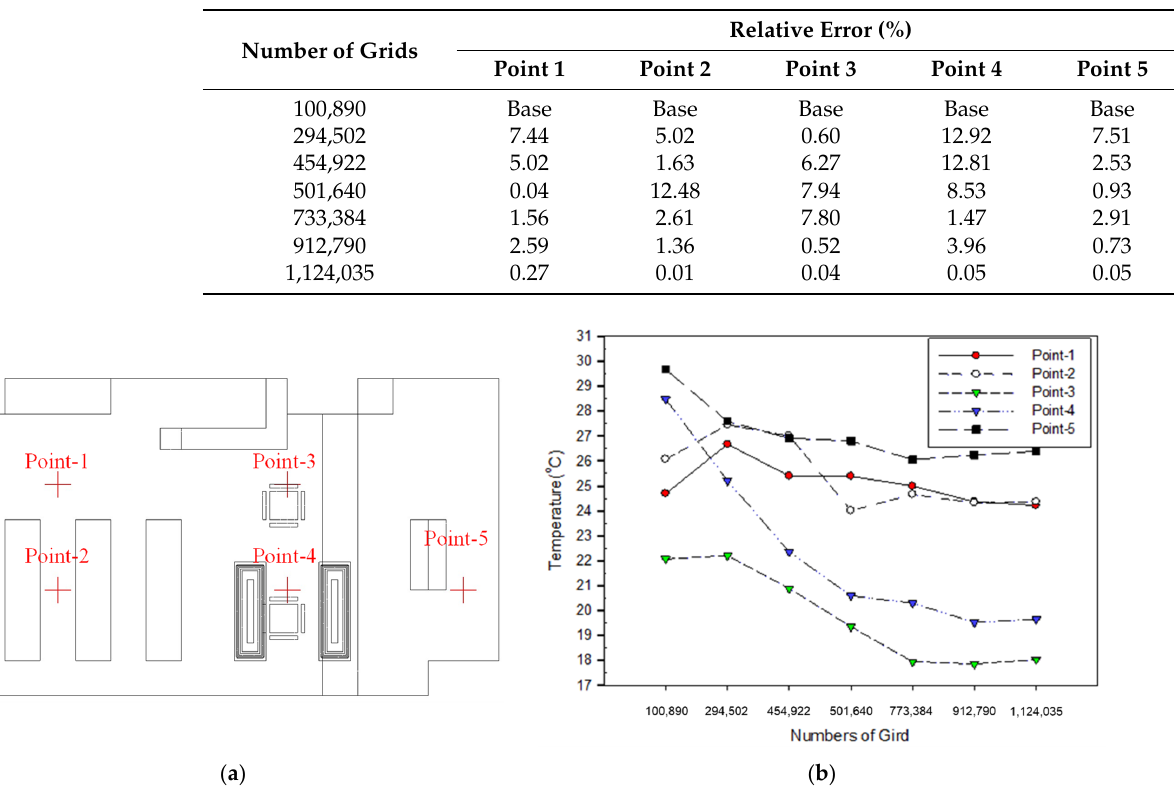
Figure 4. Grids test; ( a ) sample point location; ( b ) the number of grids.